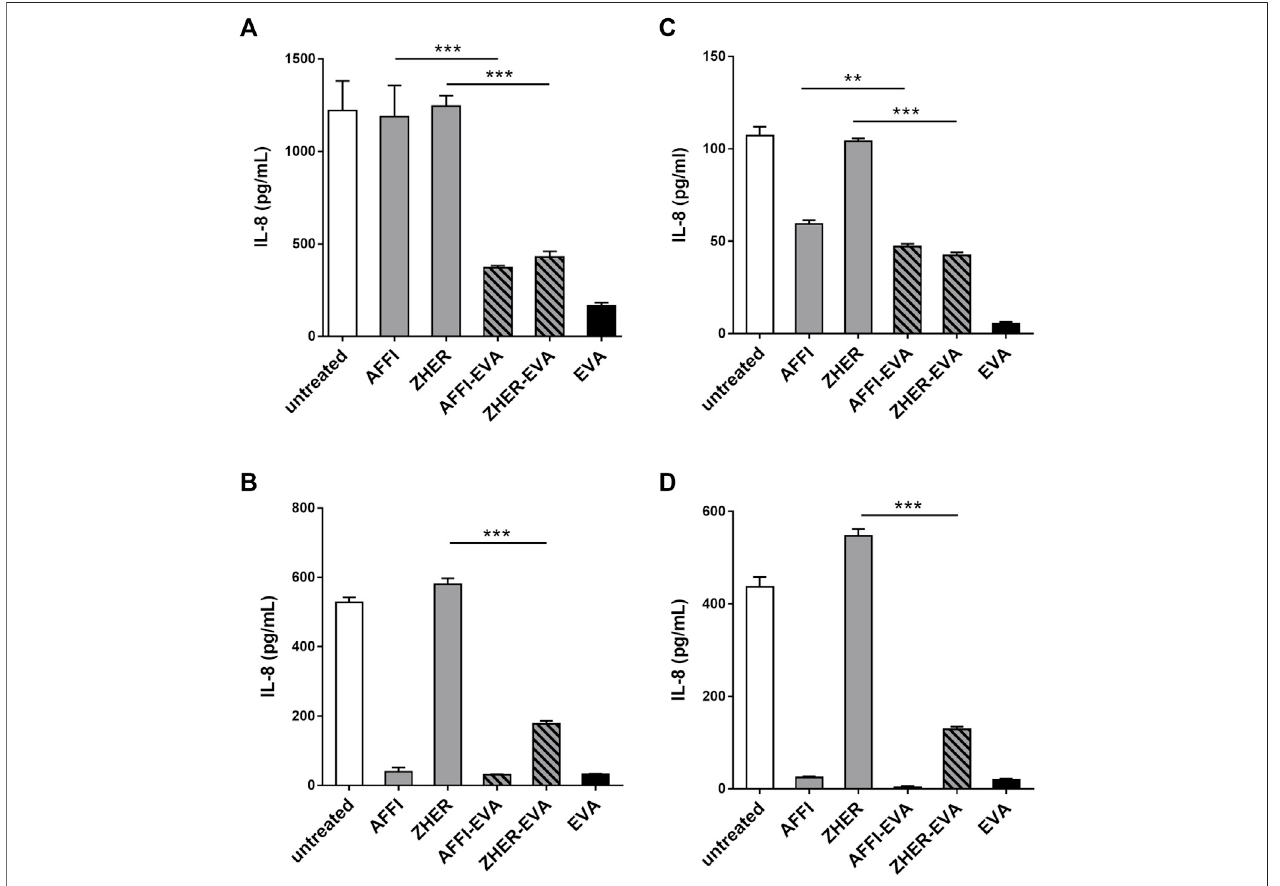
FIGURE 5 | L. lactis co-expressing IL-8 binder EVA and the tumor antigen binder AFFI or ZHER removes IL-8 secreted by Caco-2 and HT-29 cells. ELISA- determined concentrations of IL-8 after incubation of engineered L. lactis (6 × 10 9 CFU/ml) with conditioned media of IL-1 β – stimulated Caco-2 cells (A) or HT-29 cells (B) , and after co-culture with IL-1 β – stimulated Caco-2 cells (C) or HT-29 cells (D) . L. lactis strains tested: L. lactis -AFFI-EVA and L. lactis -ZHER-EVA ( L. lactis co- expressing tumor antigen binders and EVA); Negative controls: L. lactis -AFFI-IRFP and L. lactis -ZHER-IRFP ( L. lactis co-expressing tumor antigen binders and IRFP);Positive control: L. lactis -EVA ( L. lactis expressing cytokine binder EVA only). Dataare means ±SD, withexperimentsperformed in triplicate. **, p =0.001; ***, p < 0.001) (unpaired t-tests), between the relevant bacterial pairs ( L. lactis co-expressing cytokine binders and tumor antigen binders, and negative